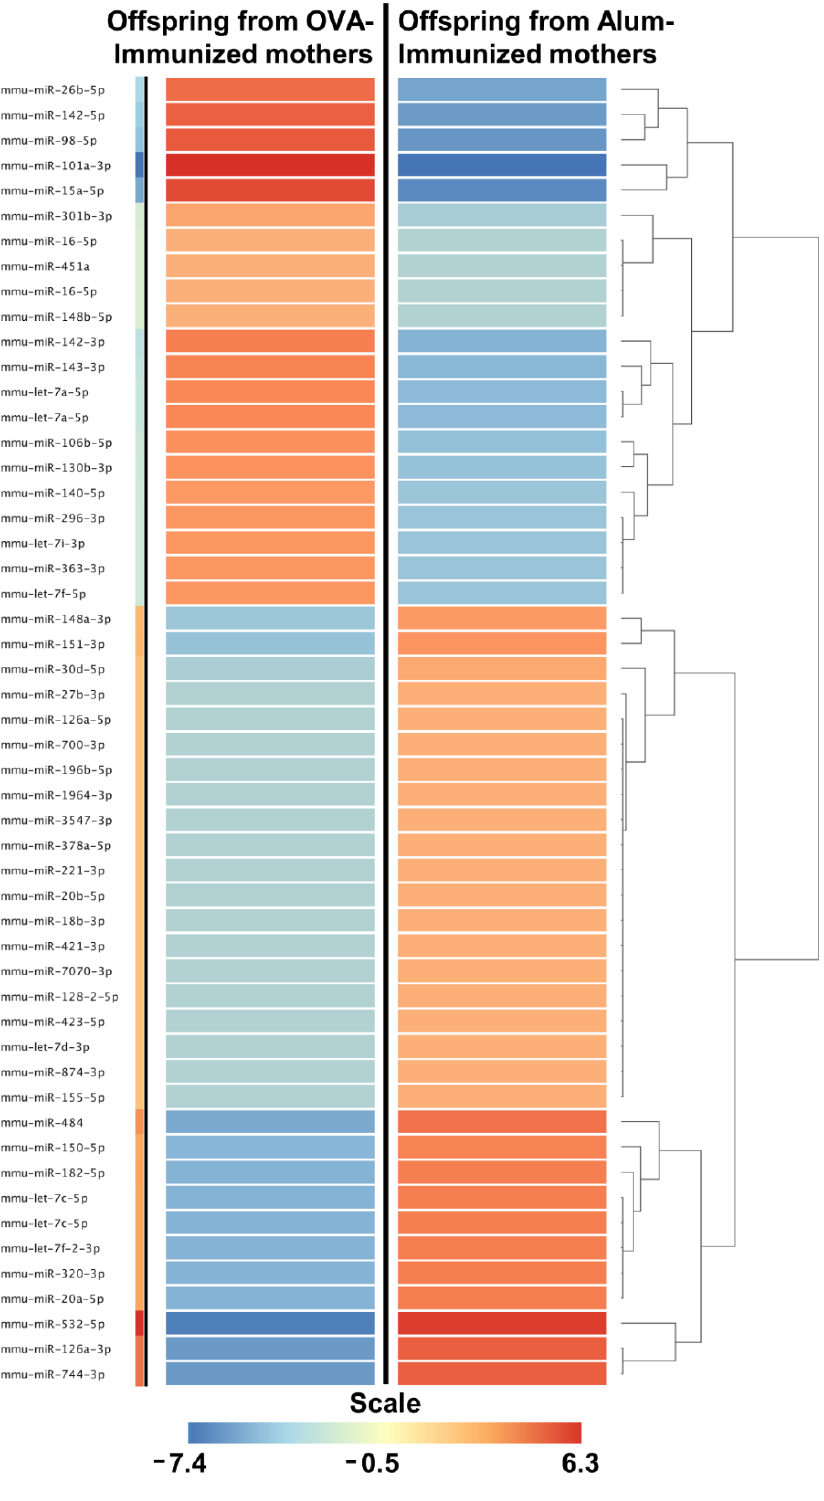
Figure 3. miRNAs that were downregulated by maternal OVA immunization. The thymus of offspring from OVA-immunized ( n = 10) or Alum-immunized ( n = 11) mothers was evaluated at three days old. Unsupervised hierarchical clustering demonstrating 52 differentially expressed mature mmu-miRs between offspring OVA-immunized and Alum-immunized mothers. The mmu-miRs clustering tree is displayed to the right, forming two major clusters. The color scale at the bottom indicates the fold change expression levels of mature mmu-miRs across in both samples: red color indicates overexpression and blue